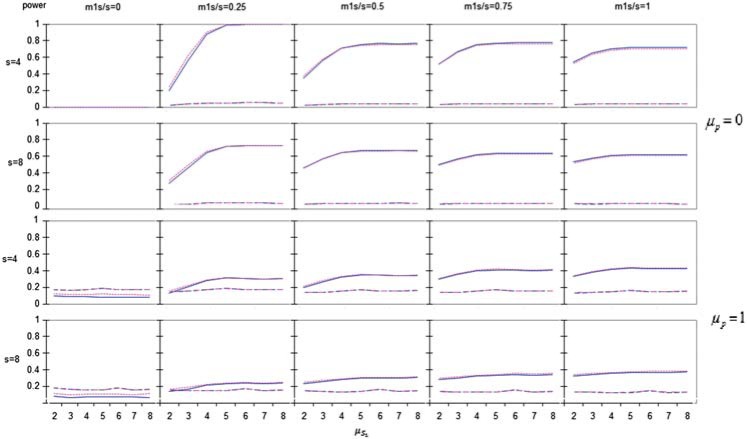
Overall power versus secondary endpoint’s parameter \documentclass[12pt]{minimal}
\usepackage{amsmath}
\usepackage{wasysym}
\usepackage{amsfonts}
\usepackage{amssymb}
\usepackage{amsbsy}
\usepackage{upgreek}
\usepackage{mathrsfs}
\setlength{\oddsidemargin}{-69pt}
\begin{document}
}{}$\mu_{S_1}$\end{document}. In the first two rows \documentclass[12pt]{minimal}
\usepackage{amsmath}
\usepackage{wasysym}
\usepackage{amsfonts}
\usepackage{amssymb}
\usepackage{amsbsy}
\usepackage{upgreek}
\usepackage{mathrsfs}
\setlength{\oddsidemargin}{-69pt}
\begin{document}
}{}$R' = 1$\end{document}, \documentclass[12pt]{minimal}
\usepackage{amsmath}
\usepackage{wasysym}
\usepackage{amsfonts}
\usepackage{amssymb}
\usepackage{amsbsy}
\usepackage{upgreek}
\usepackage{mathrsfs}
\setlength{\oddsidemargin}{-69pt}
\begin{document}
}{}$\mu_p = 0$\end{document} (which is actually power for secondary), so the overall power of the GK procedure is bounded by \documentclass[12pt]{minimal}
\usepackage{amsmath}
\usepackage{wasysym}
\usepackage{amsfonts}
\usepackage{amssymb}
\usepackage{amsbsy}
\usepackage{upgreek}
\usepackage{mathrsfs}
\setlength{\oddsidemargin}{-69pt}
\begin{document}
}{}$\alpha$\end{document} while the HWF and wBH procedures have much higher power for all different parameter values. This remains also true even when the primary endpoint has but a small effect (last two rows) where \documentclass[12pt]{minimal}
\usepackage{amsmath}
\usepackage{wasysym}
\usepackage{amsfonts}
\usepackage{amssymb}
\usepackage{amsbsy}
\usepackage{upgreek}
\usepackage{mathrsfs}
\setlength{\oddsidemargin}{-69pt}
\begin{document}
}{}$\mu_p = 1$\end{document}. Continuous blue line = HWF; dotted pink = wB-H; dashed blue = Simes GK; dashed pink = Bonferroni GK.